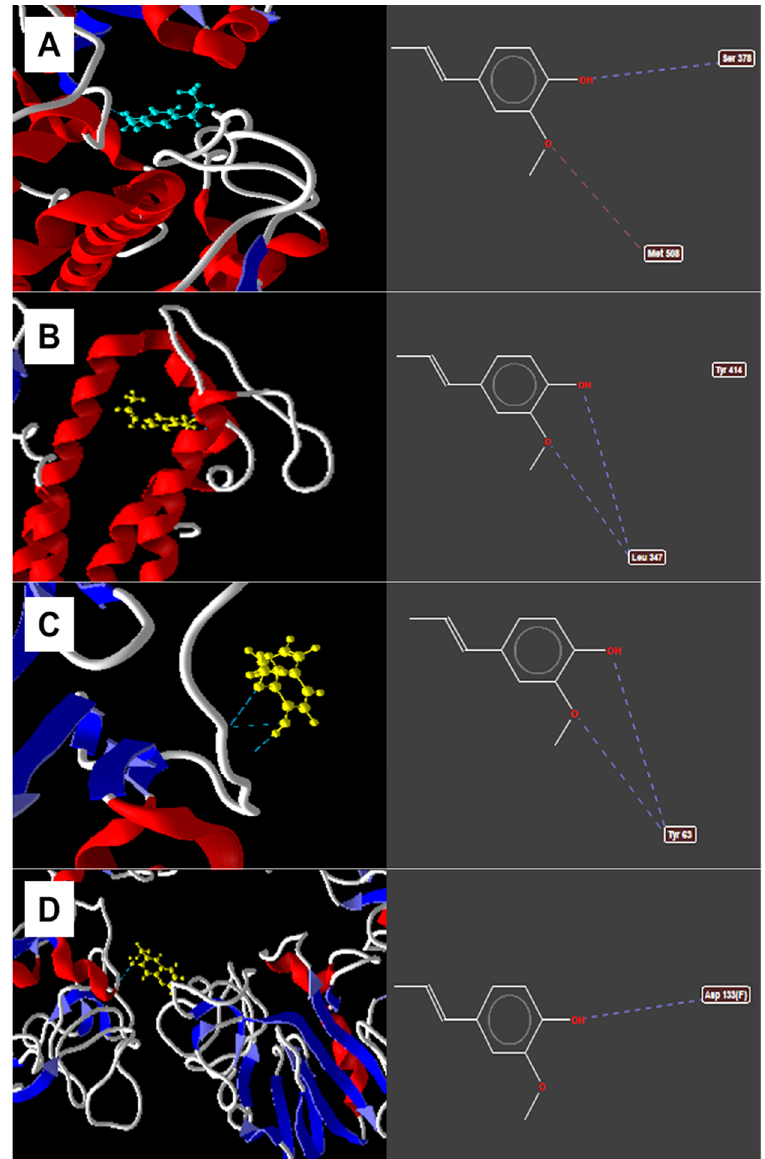
Figure3. Observedinteractionsbetweenisoeugenoland( A )14- α -demethylase, ( B )delta-14- α -reductase, ( C ) lanosterol-14- α -demethylase, ( D ) 1,3- β -glucan synthase. Dashed blue lines indicate hydrogen bonds. Dashed red lines indicate electrostatic